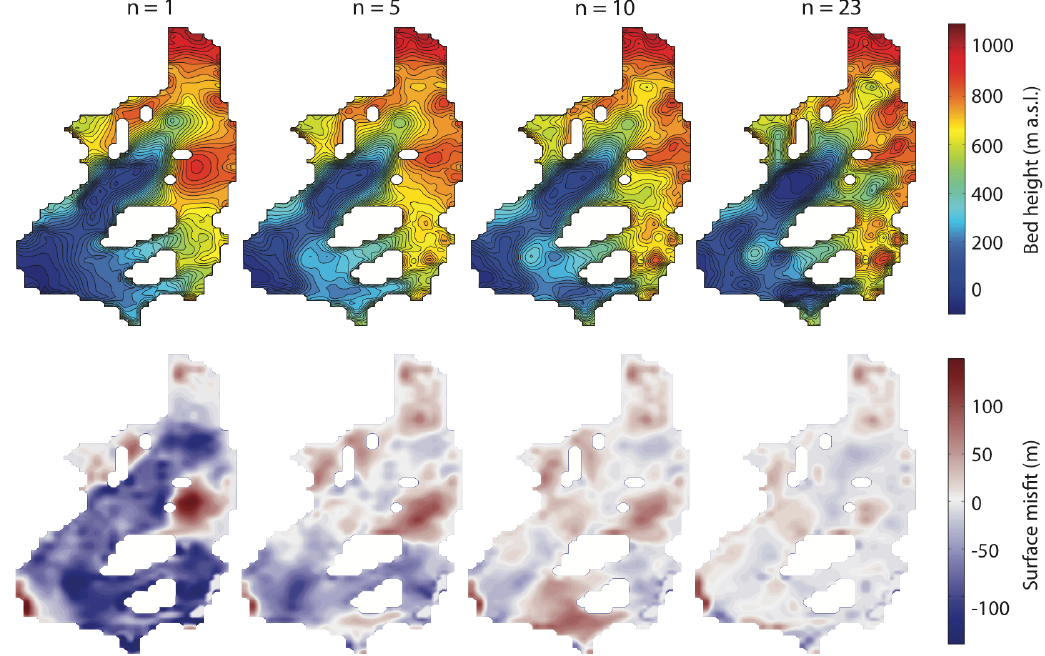
Fig. 9. Snapshots of the recovered bed (1st row) and surface height misfit (2nd row) after n = 1, 5, 10 and 23 iterations in the experiment with φ =